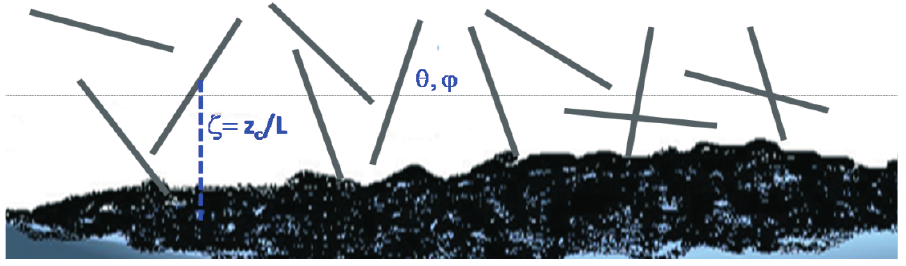
Figure1. Schematic representaion of the rigid-like macromolecular particles in the depeltion layer next to the solid surface boundary of one of the two plates which confi ne the hydrodynamic fl ow of the fl